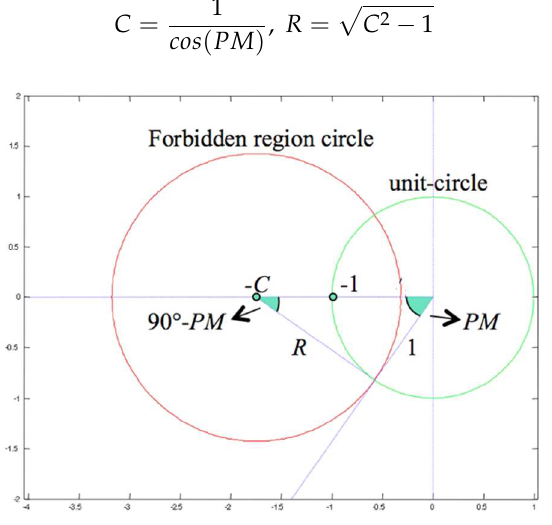
Figure 1. Forbidden region for the FO-KC auto-tuning method.